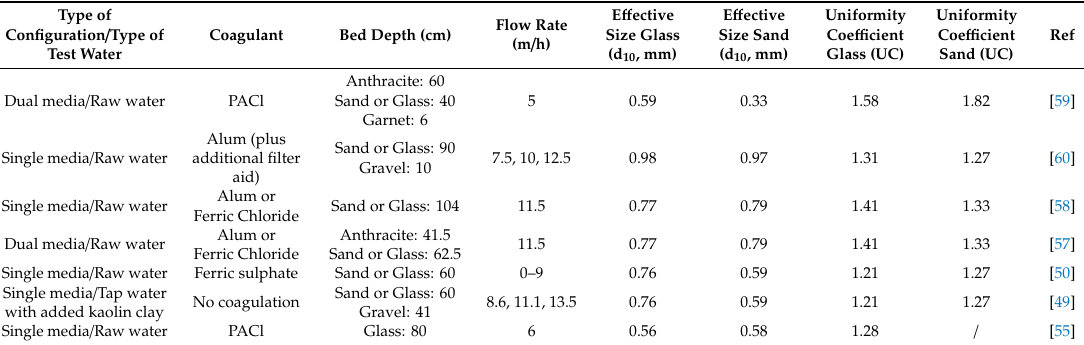
Table 2. Comparison of the relevant parameters for studies on recycled glass media.